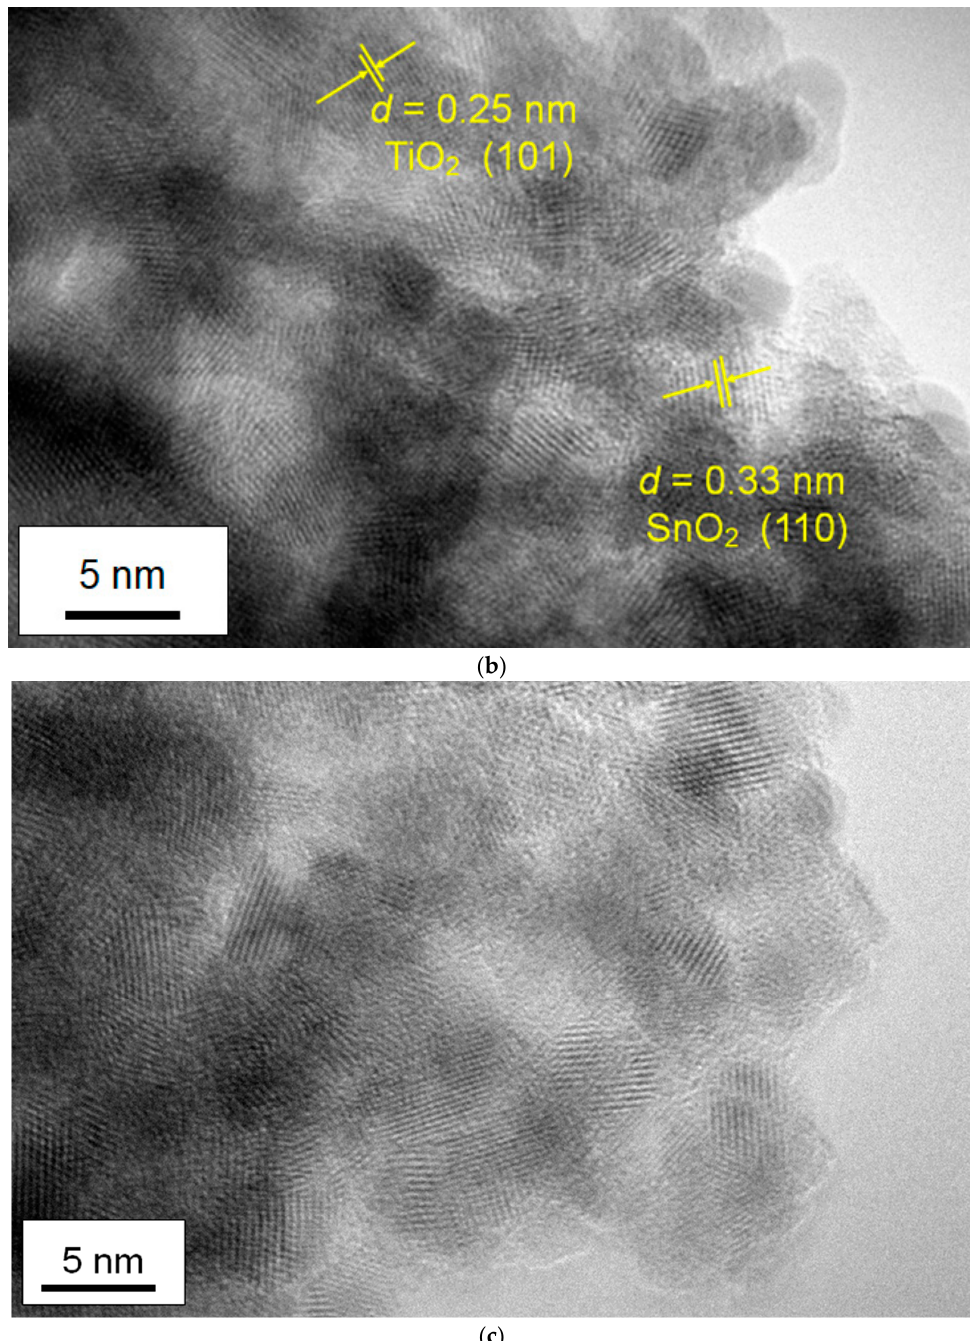
Figure 5. TEM images of the Sn/Ti oxide sample treated at 500 °C in air. The ratio of Sn/Ti in the precursor solution was 50:50. The period of maximum temperature in the sintering was 30 min. ( a ) Lower-resolution image of the Sn/Ti oxide sample. Inserted image in ( a ) presents the SAD pattern. ( b , c ) HR-TEM images measured at two different positions. ( b ) shows a d -spacing for the observed lattice fringes and lattice planes corresponding to (110) of SnO 2 and (101) of TiO 2 . In contrast, in the Sn/Ti oxide hybrid film prepared with Sn/Ti = 25:75 condition (Figure 6), the TEM measurement showed very weak crystallinity. This made it difficult to estimate the primary particle sizes because of the aggregation of the particles.